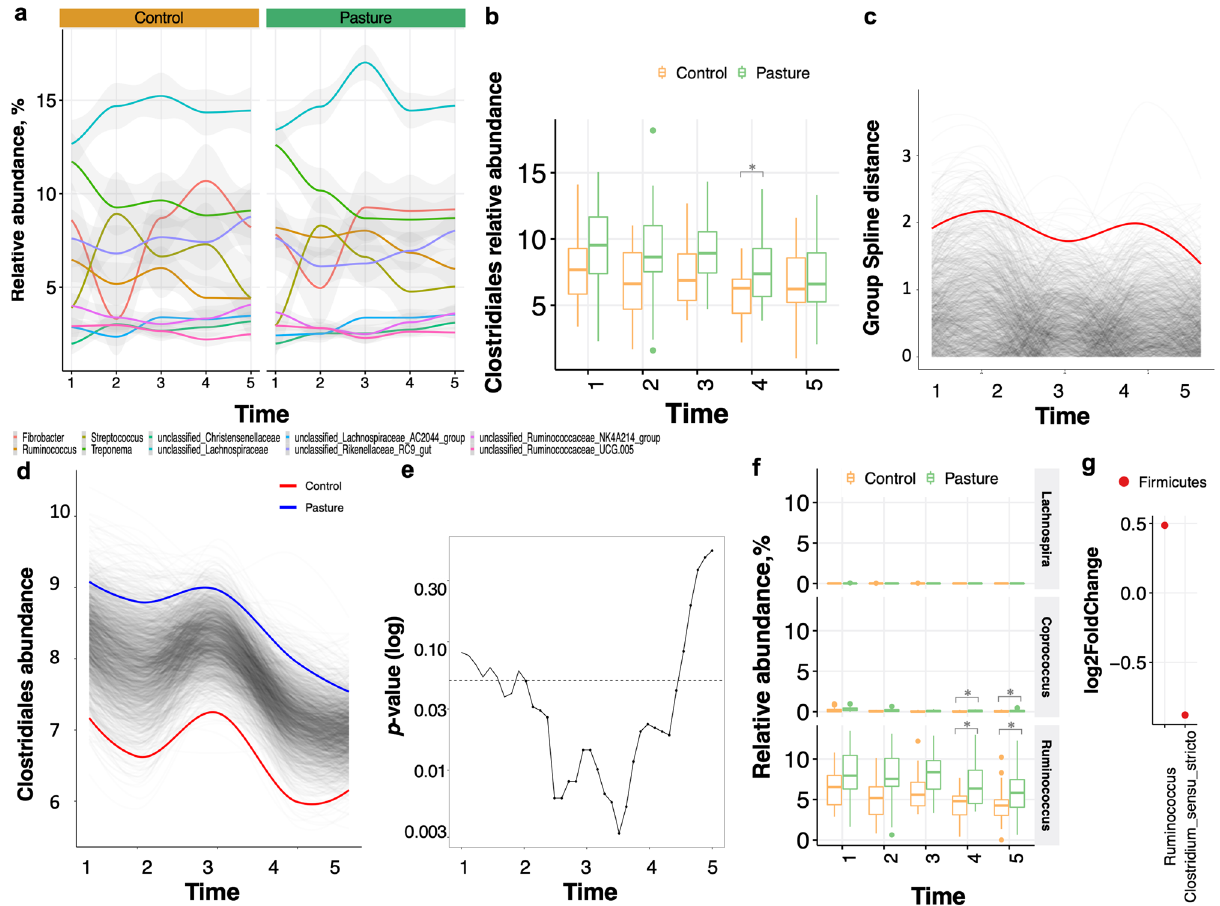
Figure 4. Longitudinal fecal microbiota composition differences between groups. ( a ) The longitudinal variation of the 10 most abundant genera in the horse fecal microbiota between groups. Graph shows relative abundance (y axis) of the most common bacterial genera over time (x axis), averaged across control and pasture group; ( b ) box plot representation of the relative abundance of Clostridiales between groups and across time. The box plots feature the median (center line) and interquartile range, and whiskers indicate 5th to 95th percentile; ( c ) permuted spline tests for statistical significance using the entire 27-month time series. Group distance plot for the Clostridiales comparison. The graph shows that permuted splines support a trend toward a greater true statistical difference after T3. The observed difference between the groups exceeded the random permuted distribution, which supports the statistically significant finding ( p < 0.05); ( d ) Clostridiales abundance was different between pasture group (group spline in blue) and control horses (group spline in red; 9,999 permutations, p < 0.05); ( e ) the plot output of the sliding spliner function shows a window of significance between the T3 and T4 time points. The p -value at each specified interval derived from the distribution of points from individuals’ smoothed splines. Dotted line indicates p = 0.05; ( f ) box plot representation of the relative abundance of the single taxa included within Clostridiales between groups and across time. The box plots feature the median (center line) and interquartile range, and whiskers indicate 5th to 95th percentile. Asterisk indicates p < 0.05; ( g ) dot plot representation of log-transformed fold change of genera that were significantly different between pasture and control across time using DESeq2. The log of fold changes superior to 0 indicate that genera were more abundant in pasture individuals than control individuals at any time of the experiment. By contrast, the log of fold changes inferior to 0 indicate that the genera abundances were lower in pasture relative to control individuals. Dots are colored by phyla. All plots were produced in R software https ://www.r- proje ct.org, using the version